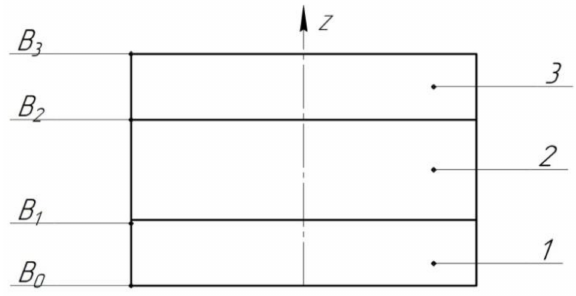
Figure 1. Geometry of the solution area (birch leaf): 1 is the dry organic matter layer; 2 is the layer representing a mixture of dry organic matter and water; 3 is the dry organic matter layer. Information from [54] was used to assign thicknesses to specific